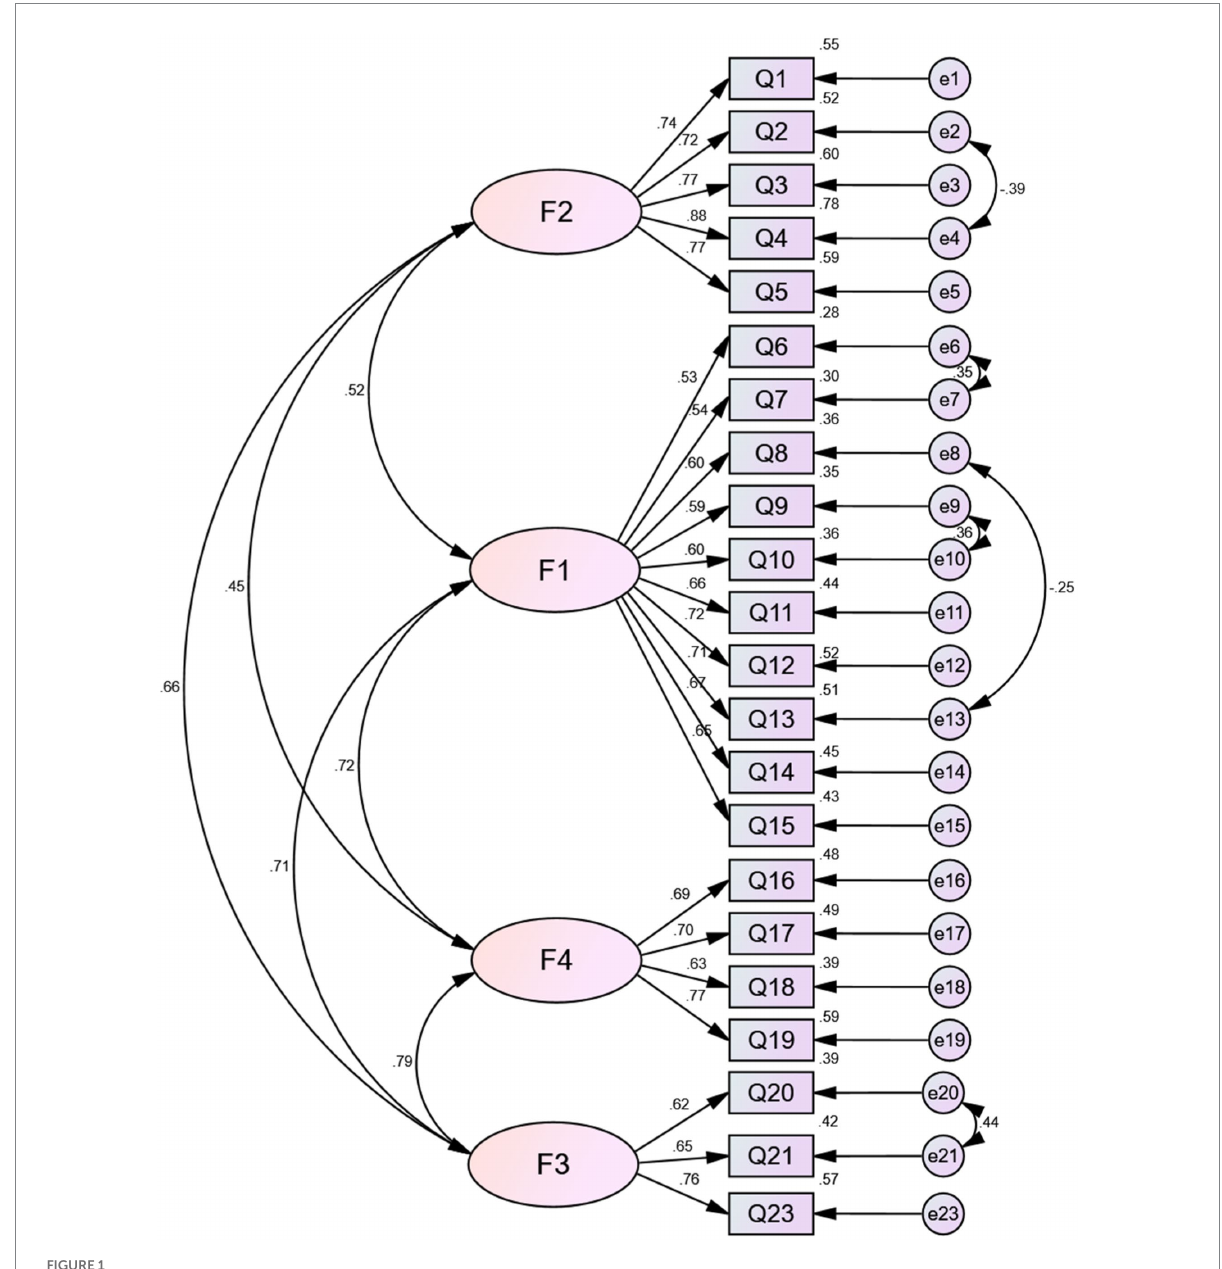
FIGURE 1 Structural equation model of health